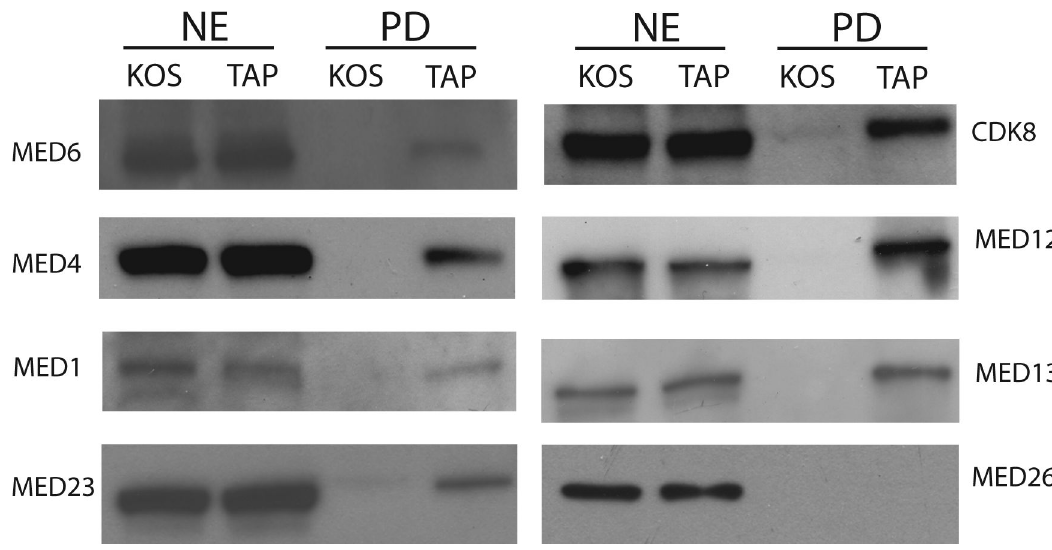
Figure 4. Components from all modules of Mediator are found in TAP-wtICP4 samples. Western blot analysis of nuclear extracts (NE) or affinity purified (PD) samples using either wtICP4 (KOS) or TAP-wtICP4 (TAP) expressing viruses at 6 hpi. Results of the Western blot analysis for components of the head (Med6), middle (Med4 and Med1), tail (Med23), kinase (cdk8, Med12, and Med13), and the Med26 protein are shown.